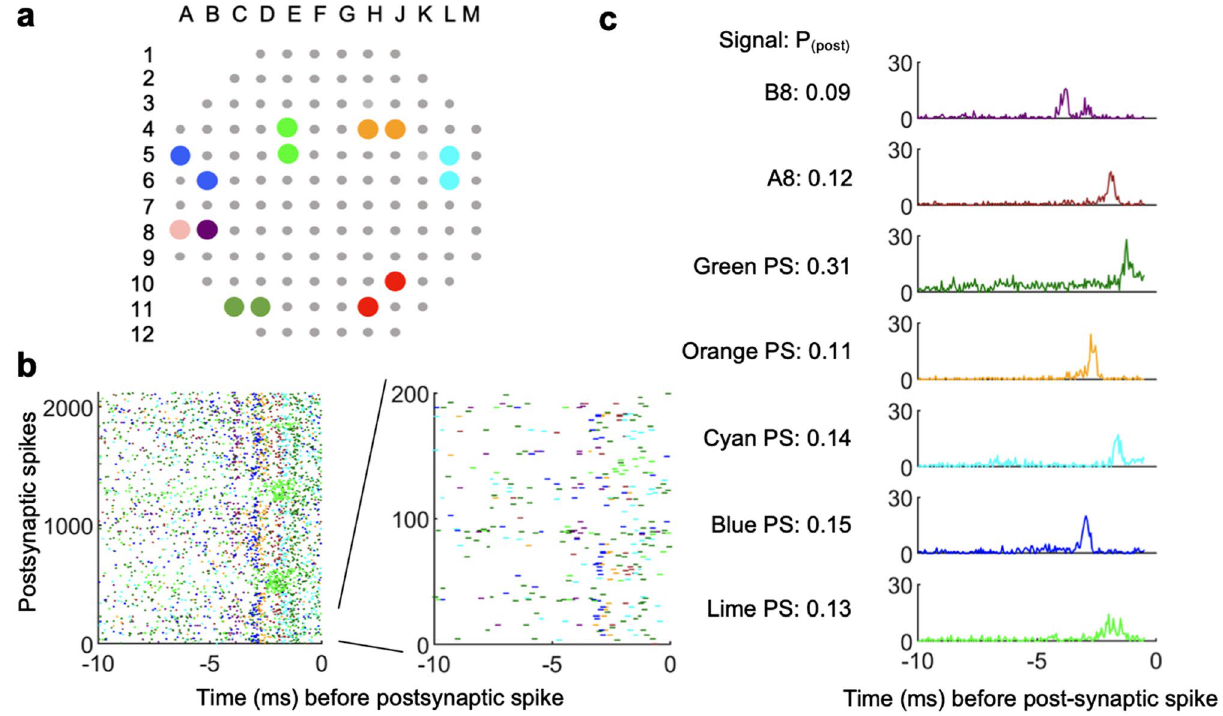
Figure 6. The influence of presynaptic inputs on a single postsynaptic propagation signal. ( a ) Location of the post-synaptic neuron in red and upstream signals in other colors. Dots in different colors represent different upstream signals. Each two dots in the same color represent two anchor points for one propagation signal. Pink and purple represent two single electrode units. ( b ) The patterns of pre-synaptic spikes. Each row shows the pre-synaptic firing pattern within 10 ms prior to corresponding spike on the red neuron. The first 200 instances are zoomed in on the right. The colors are consistent with ( a ). ( c ) CCGs for all upstream signals. Postsynaptic spikes (red propagation signal, n = 2124 spikes) were used as reference time points to perform CCG on other propagation signals and single electrodes A8 and B8. Because the postsynaptic spikes were used as the reference time points, the coupling probability was calculated by taking the ratio of presynaptic spikes in the CCG peak over the total number of postsynaptic spikes (1 MEA and a single recording session was used for ( a – c